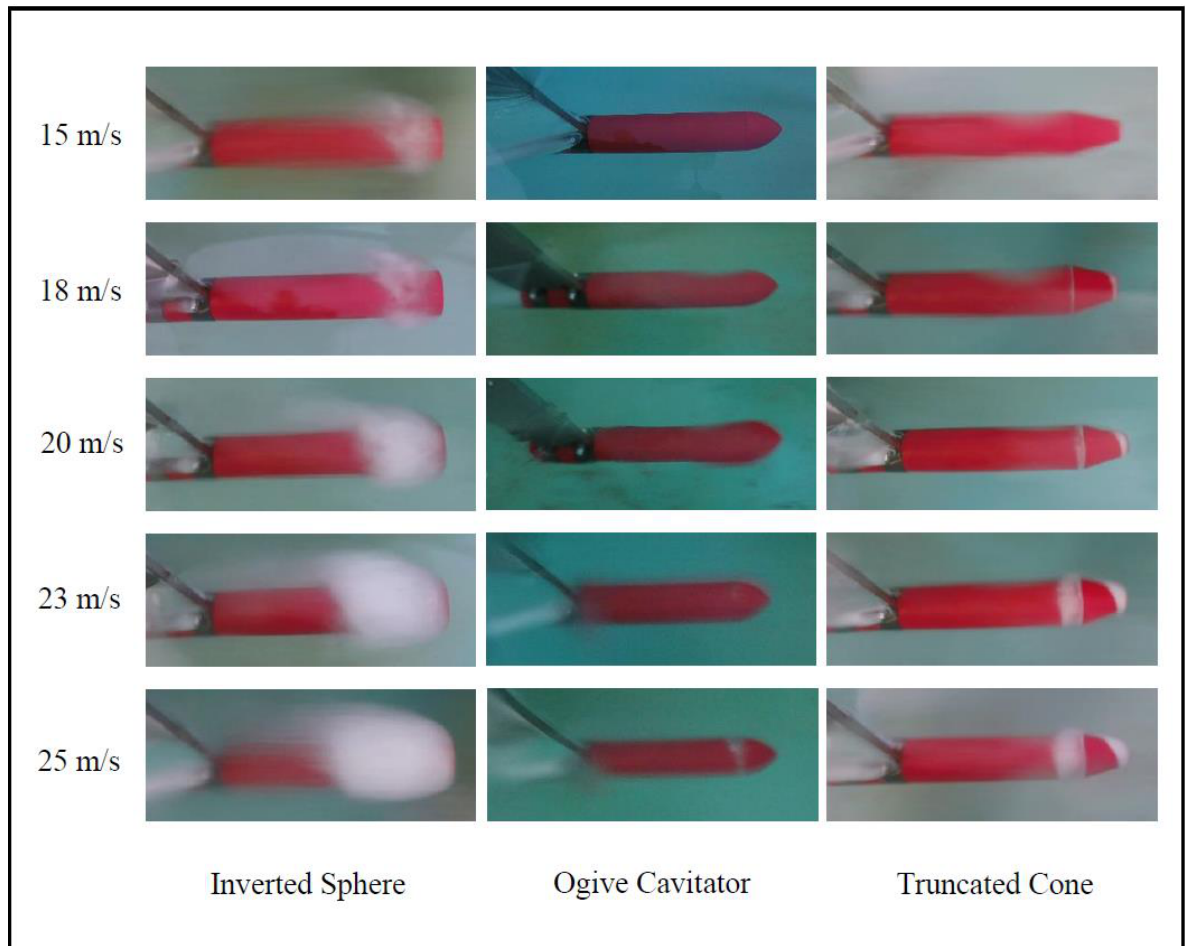
Figure 5. Bubble development for inverted sphere, ogive, and truncated cone cavitators at different cruise